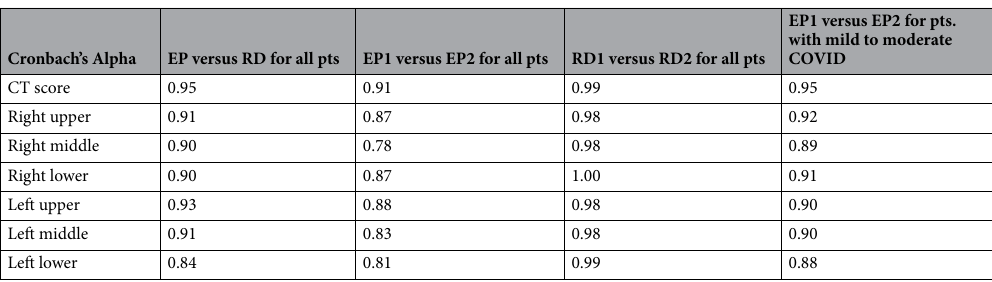
Table 3. Agreement in scores between paired evaluators. EP emergency physicians, RD radiologists, pts patients.